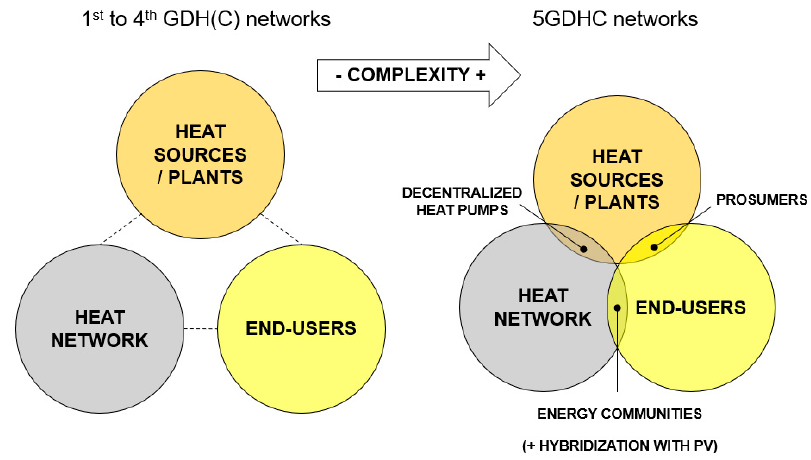
Figure 5. Modeling of 5GDHC is characterized by an increase in complexity with respect to previous DHC generations.